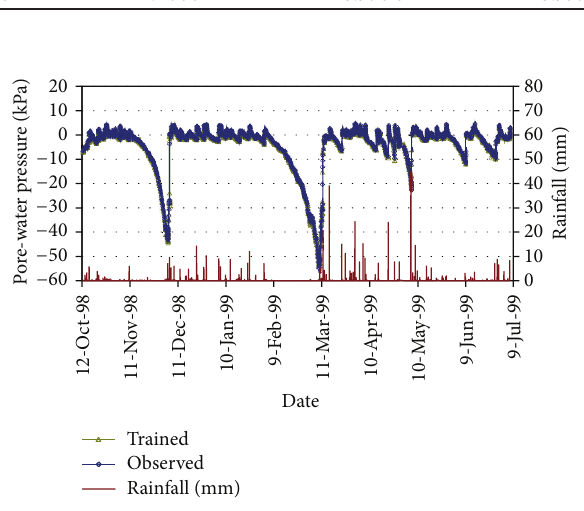
Figure 5: Comparison between observed and trained time series of pore-water pressures obtained from training the ANN